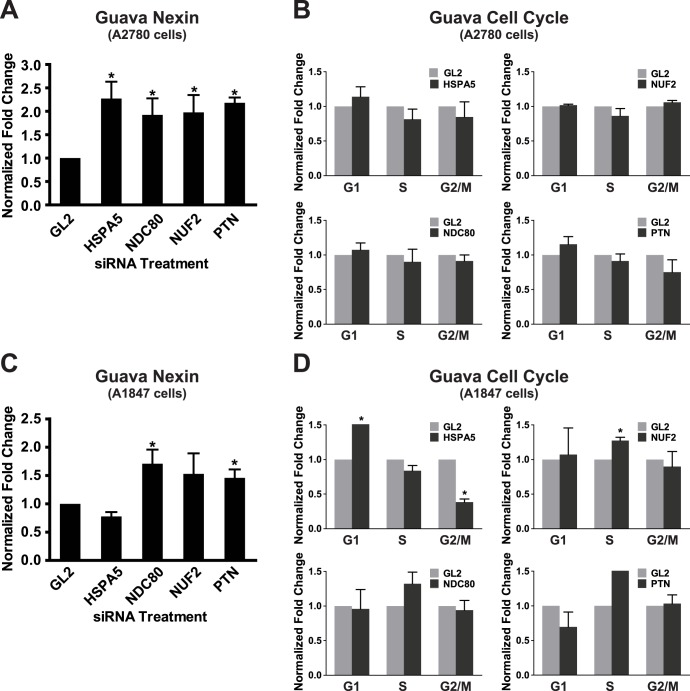
Effect of gene silencing on cell survival and cell cycle progression.A1847 and A2780 cells were transfected with HSPA5, NDC80, NUF2, PTN or GL2 siRNAs. Seventy-two hours post-transfection, cells were harvested and processed for analysis of apoptosis or cell cycle progression. A. & C. The fraction of apoptotic cells was measured by annexin V staining followed by enumeration by using a Guava flow cytometer (Millipore). The fold-change in apoptotic cells is shown (mean ± SD, n = 3). B & D. The fraction of cells in each phase of the cell cycle was measured by propidium iodide staining followed by enumeration using the Guava instrument. The fold-change for each cell cycle phase is shown (mean ± SD, n = 3).